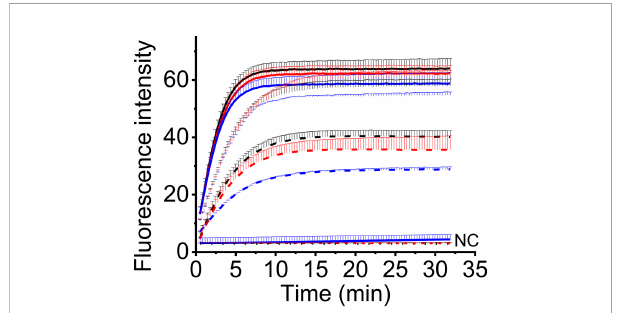
FIGURE 5 The real-time fl uorescent intensity of different RT-RAA/CRISPR- Cas12a operation for different MCMV RNA amount. Black line, one- step operation; red line, two-step operation (10 m L RT-RAA buffer/10 m L CRISPR buffer); blue line, two-step operation (2 m L RT-RAA buffer/18 m L CRISPR buffer). Solid lines indicate the 9.6 ng total RNA; short dot lines indicate 9.6 × 10 -3 ng total RNA; short dash dot lines indicate 9.6 × 10 -4 ng total RNA. DNase/RNase-free deionized water was used as the negative control